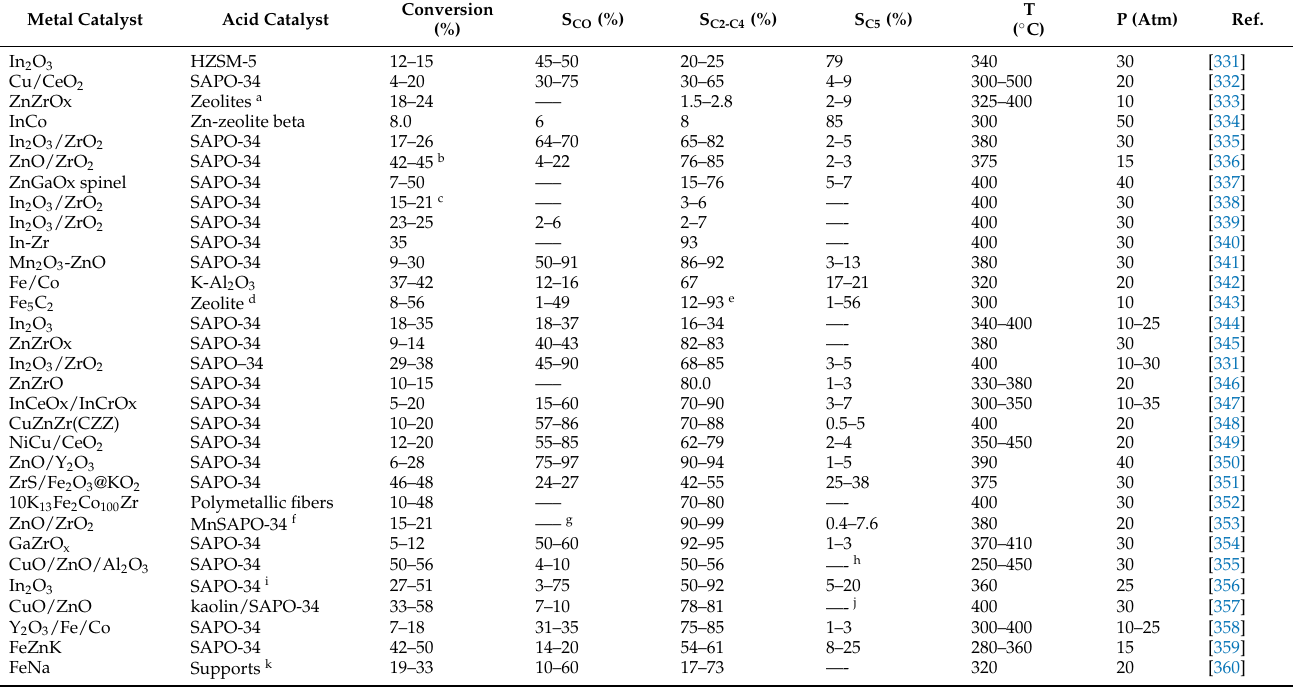
Table 10. Comparative summary of different bifunctional/hybrid catalytic systems for the MTO process for improving the direct conversion of CO 2 to light